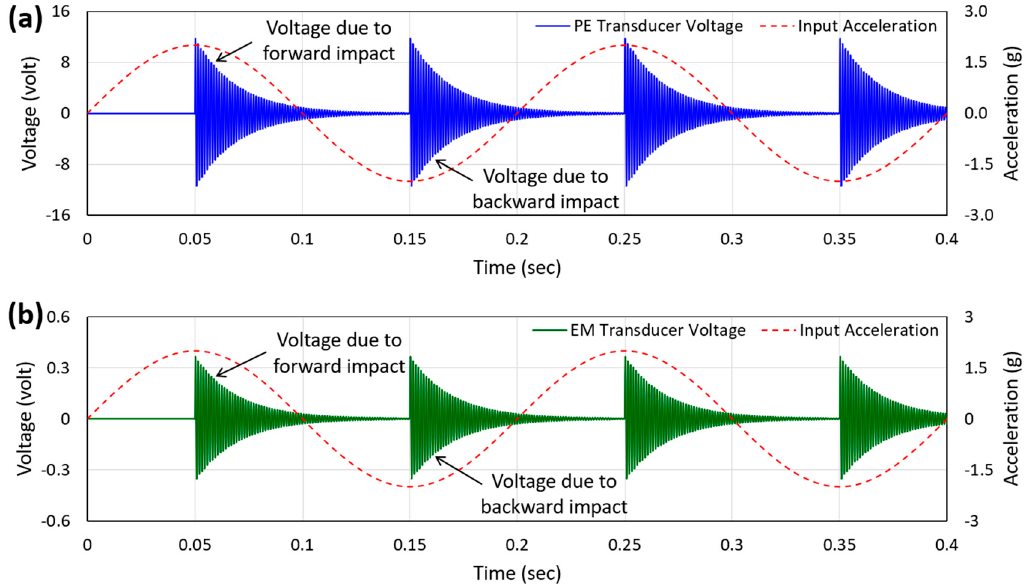
Figure 3. Simulated open circuit voltage waveforms of the piezoelectric ( a ) and electromagnetic ( b ) transducers at 5 Hz excitation frequency and 2 g peak acceleration. ( b ) transducers at 5 Hz excitation frequency and 2 g peak